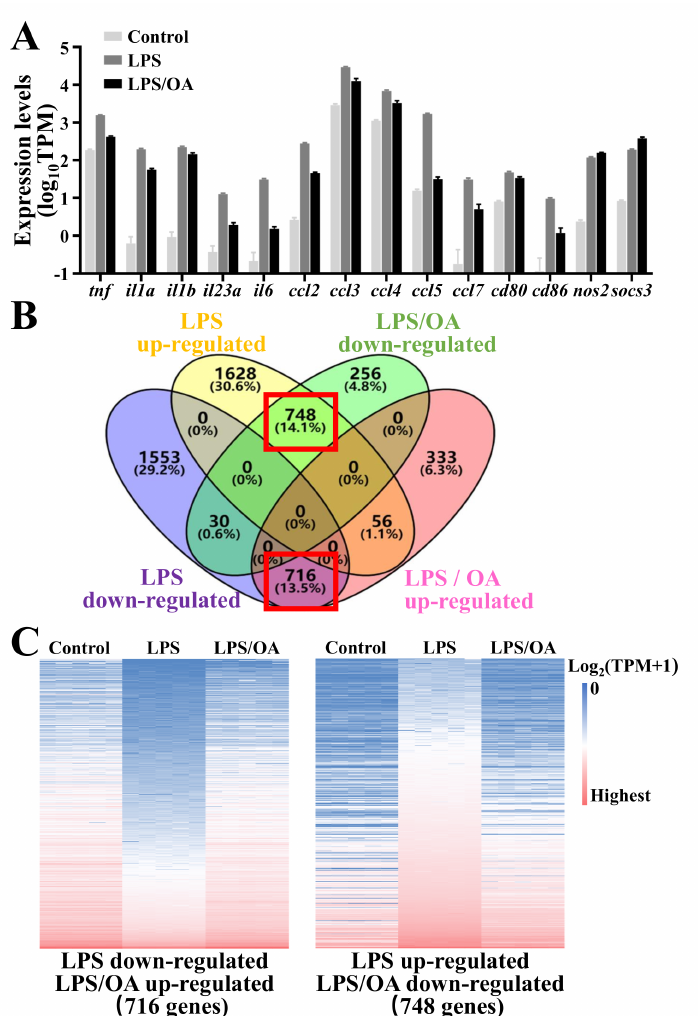
Figure 5. OA treatment partly recovers altered gene expression induced by LPS. (A) Averaged expressions of inflammation-related genes in the RNA-seq analysis. (B) Venn diagram of the RNA-seq results. Red rectangles indicated place of interests. The percentage of gene enclosed in each catalog was enclosed in the bracket. (C) Ordered expression profiles of genes involved in the red rectangles in B. The color of the block indicated expression level of the sample in the form of log 2